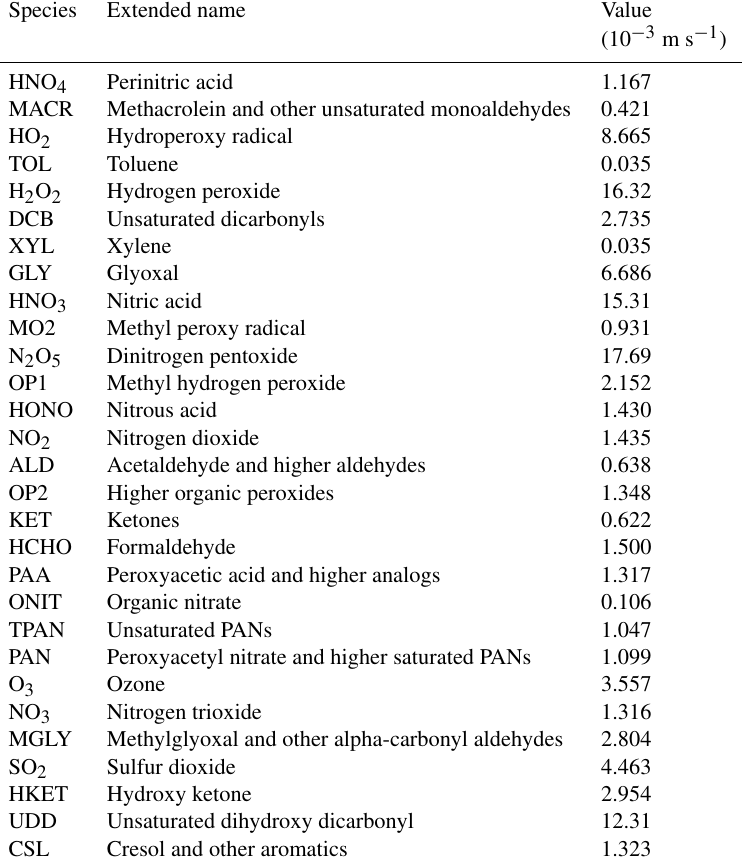
Table 4. Surface dry deposition velocity used for all QG-Chem experiments. Values are equal to a fixed and low deposition velocity of 10 − 5 ms − 1 for chemical species that are not listed